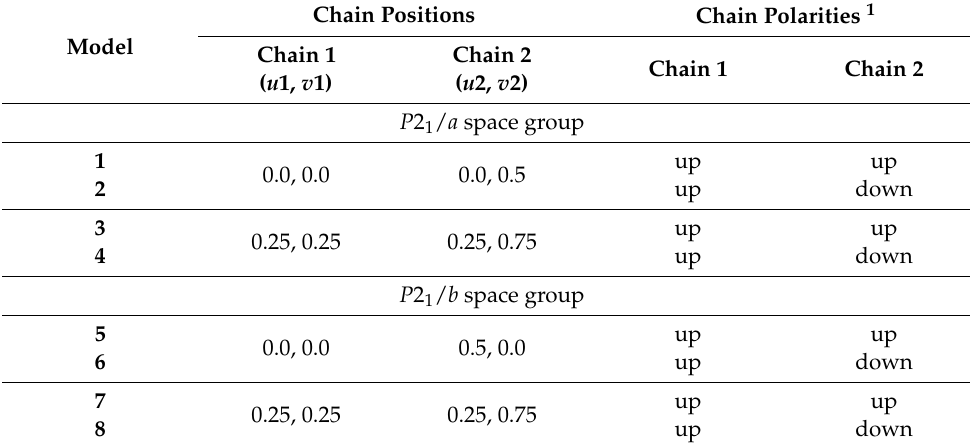
Table 1. Chain packing modes of chain packing models.